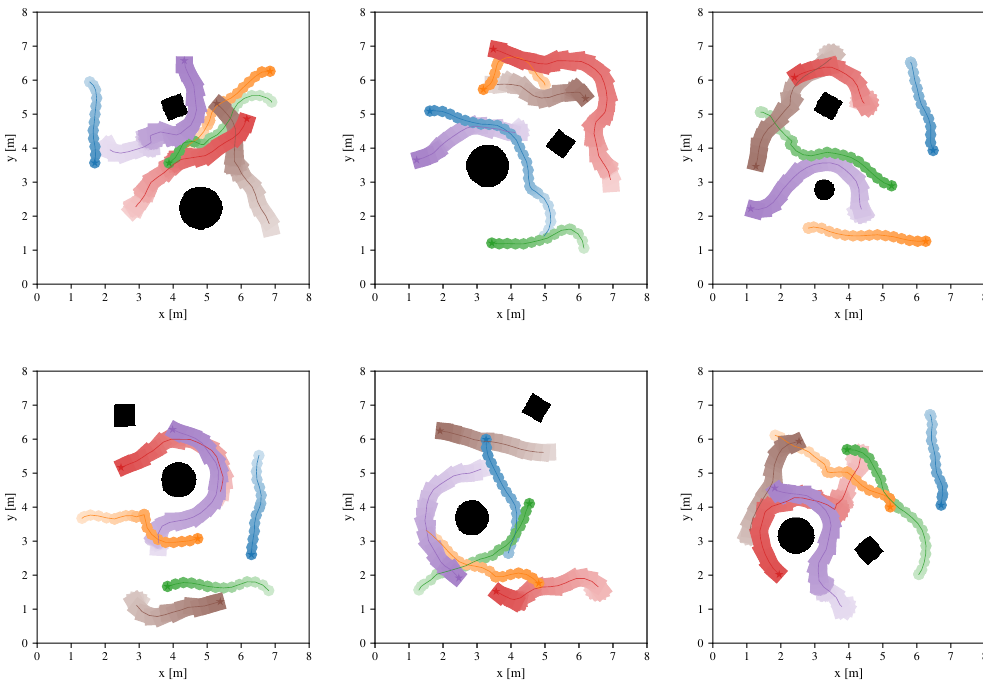
Figure 7. The scenario with heterogeneous robots, which contains three rectangular robots, three circular robots and obstacles with different shapes. All robots are controlled by the same learned collision avoidance